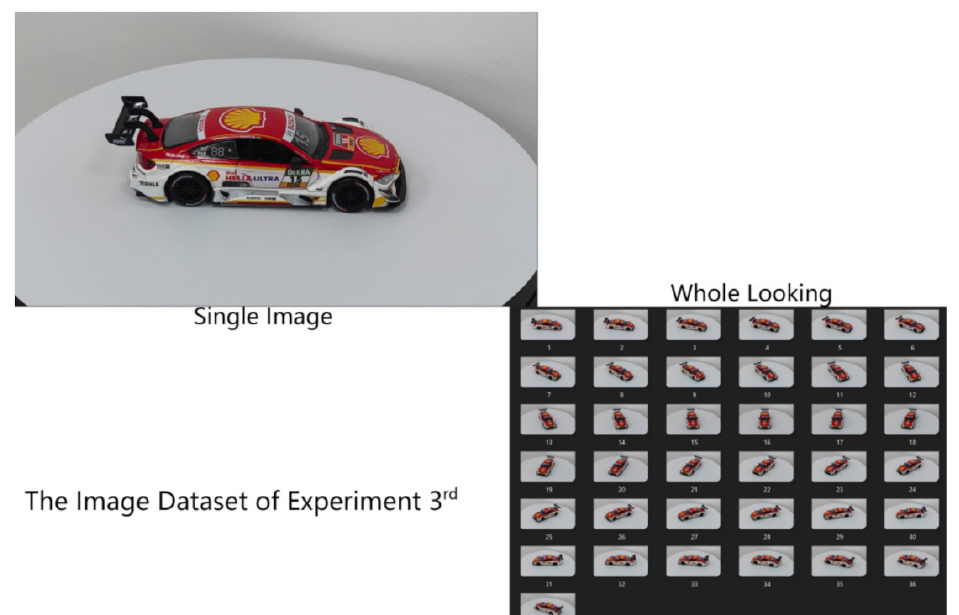
Figure 17. The image dataset used in experiment